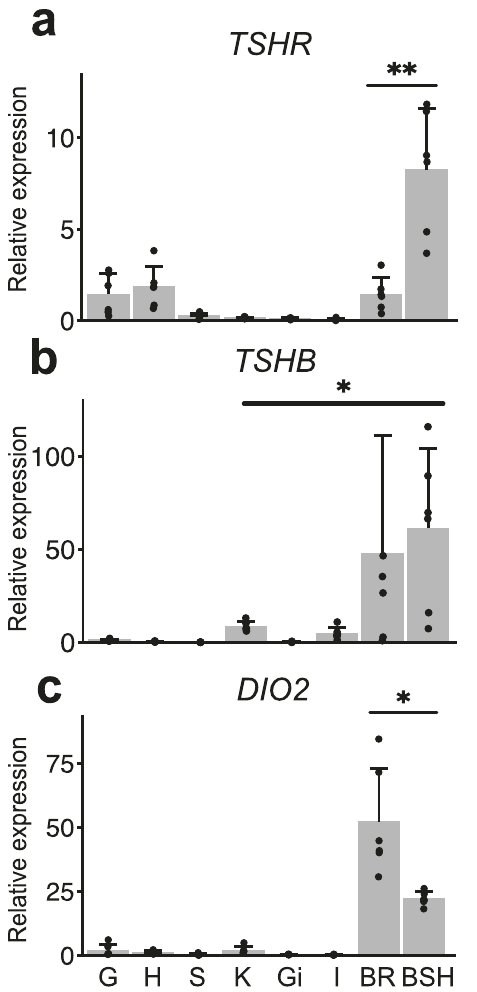
Fig. 4 Tissue expression of three key genes ( TSHR , TSHB and DIO2 ) involved in the photoperiodic signaling pathway examined by quantitative PCR. a TSHR . b TSHB . c DIO2 . Tissues that were used in the experiment include gonad (G), heart (H), spleen (S), kidney (K), gills (Gi), intestine (I), hypothalamus and saccus vasculosus (BSH), and brain without BSH (BR). The average expression level of each gene in the gonad is assumed to be 1, error bars represent the SDs calculated from six biological replicates ( N = 6). Unpaired two-tailed Student ’ s t test was used for the statistical analysis. *: P < 0.05, **: P <